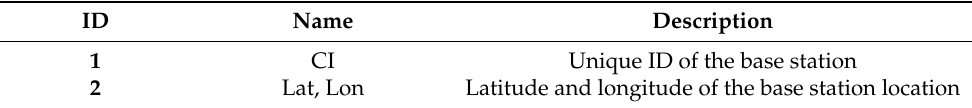
Table A2. The inner structure of GSM engineering parameters.